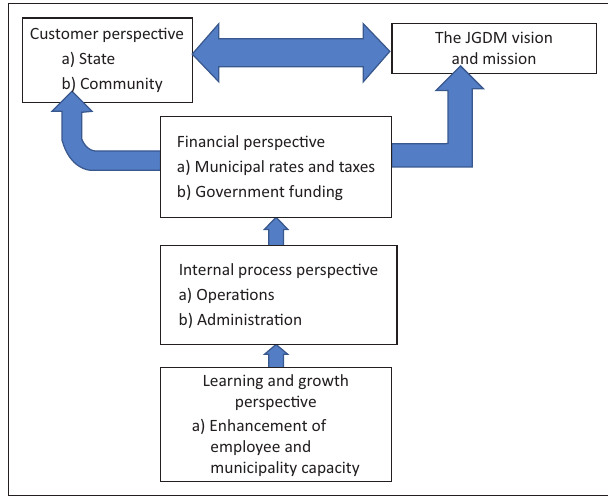
FIGURE 3: A design of an ideal scorecard framework.